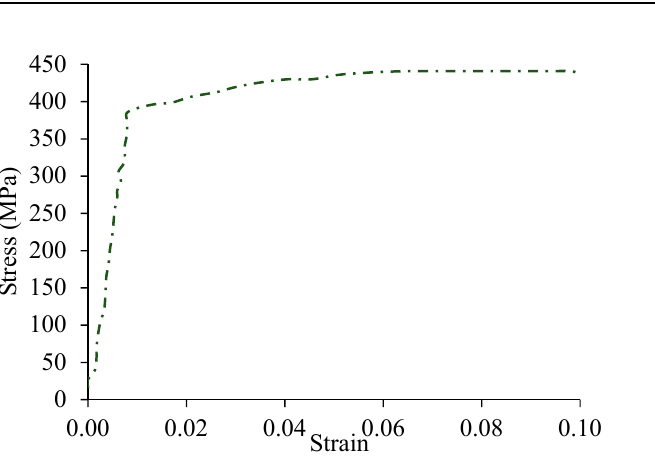
Figure 2. Plastic behavior of steel reinforcement material.